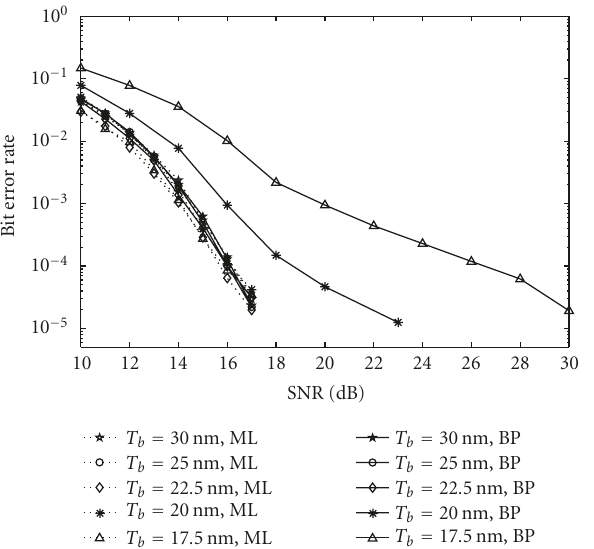
Figure 9: Performance for bit-patterned media storage system with media noise levels.